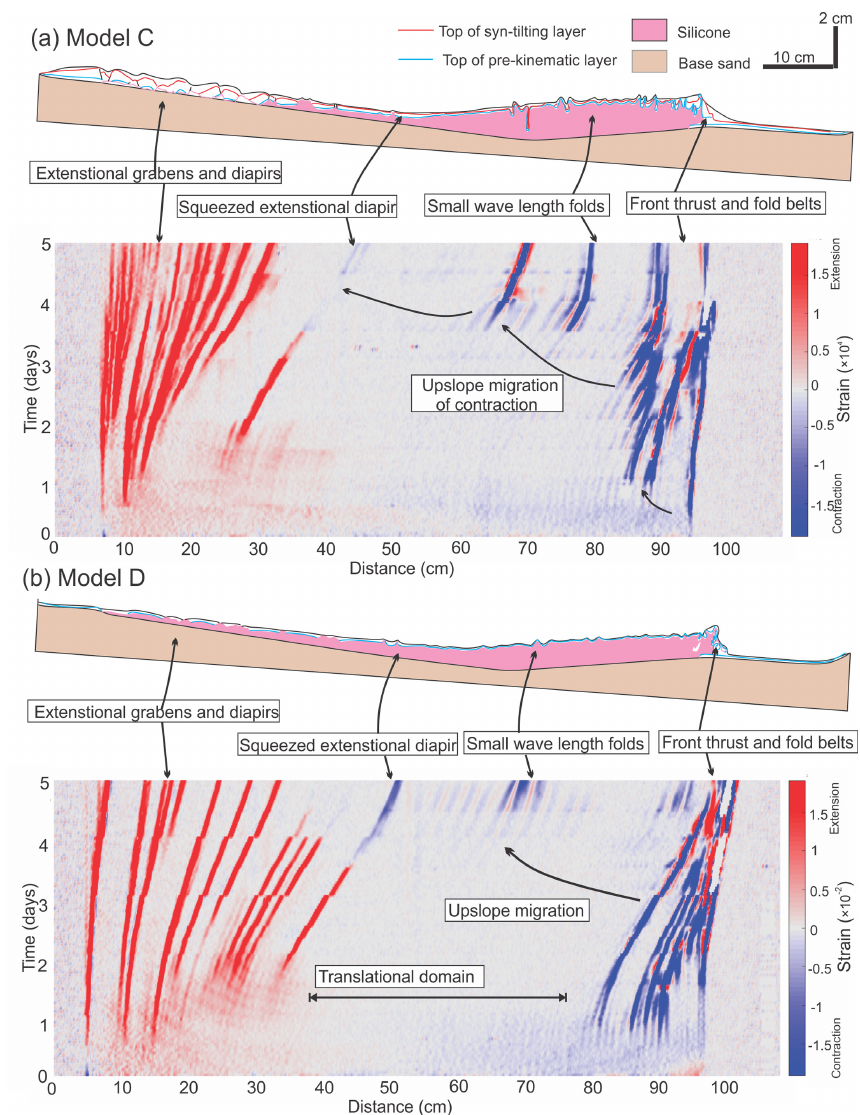
Figure 7. (a) Structural styles and kinematic domain partition in central section of Model C. The strain evolution diagram (showing incre- mental strain at 1h intervals, or strain rate in 1/h) along the central section beneath shows the initiation of extensional and contractional structures and how they evolve in space and time. Note the squeezed diapir due to the upslope migration of contractional domain. (b) Struc- tural styles and kinematic domain partition in central section of Model D. The strain evolution diagram (showing incremental strain at 1h intervals, or strain rate in 1/h) along the central section shows the evolution of extensional and contractional structures in space and time. Note the overall kinematic and structural evolution of Model D are similar to Model A–C despite no differential loading from wedge-shaped syn-kinematic